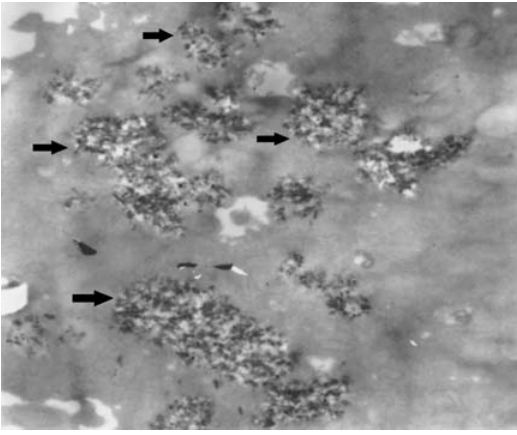
The endosomal vesicles (arrows) containing superparamag- netic iron oxide (SPIO) particles appear inside the mesenchy-